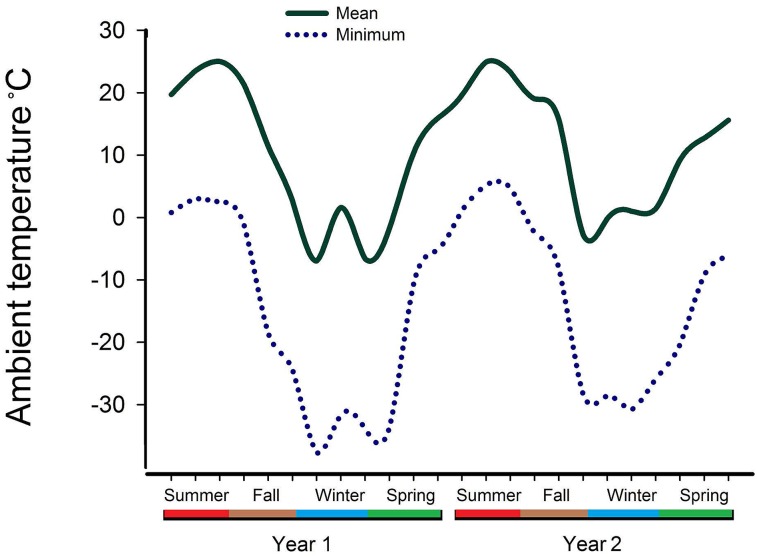
Mean and minimum temperatures (°C) for a location equidistant from the slaughter plantsz between June 1, 2013 and May 31, 2015.Ambient temperature (°C).